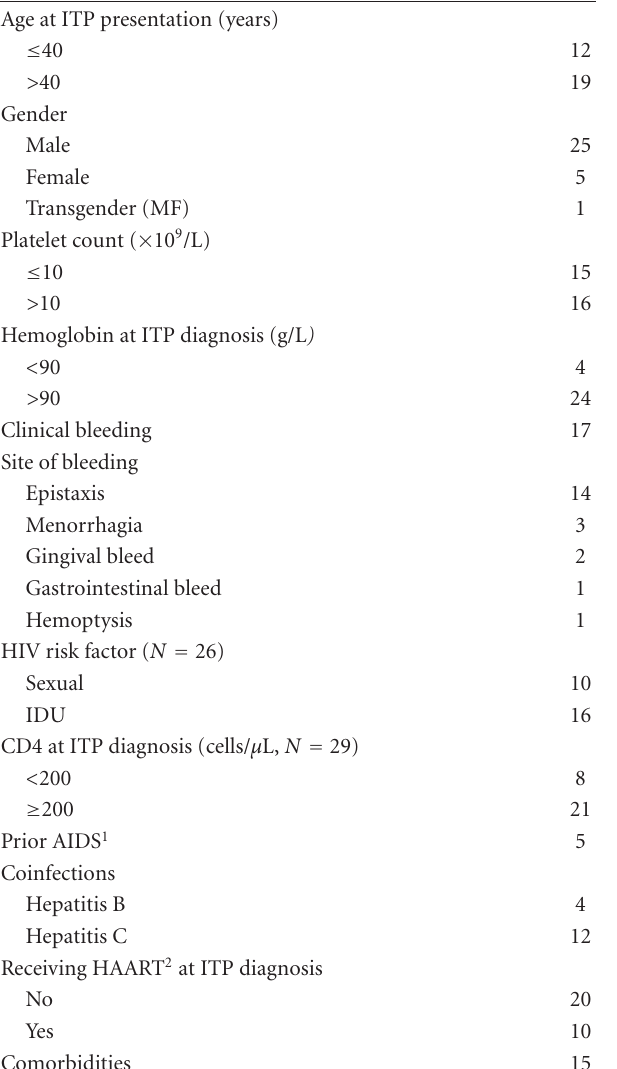
Table 1: Clinical characteristics of 31 patients with HIV-associated ITP diagnosed since 1996.